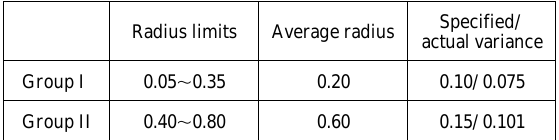
Table 1 Characteristic distribution values of particle